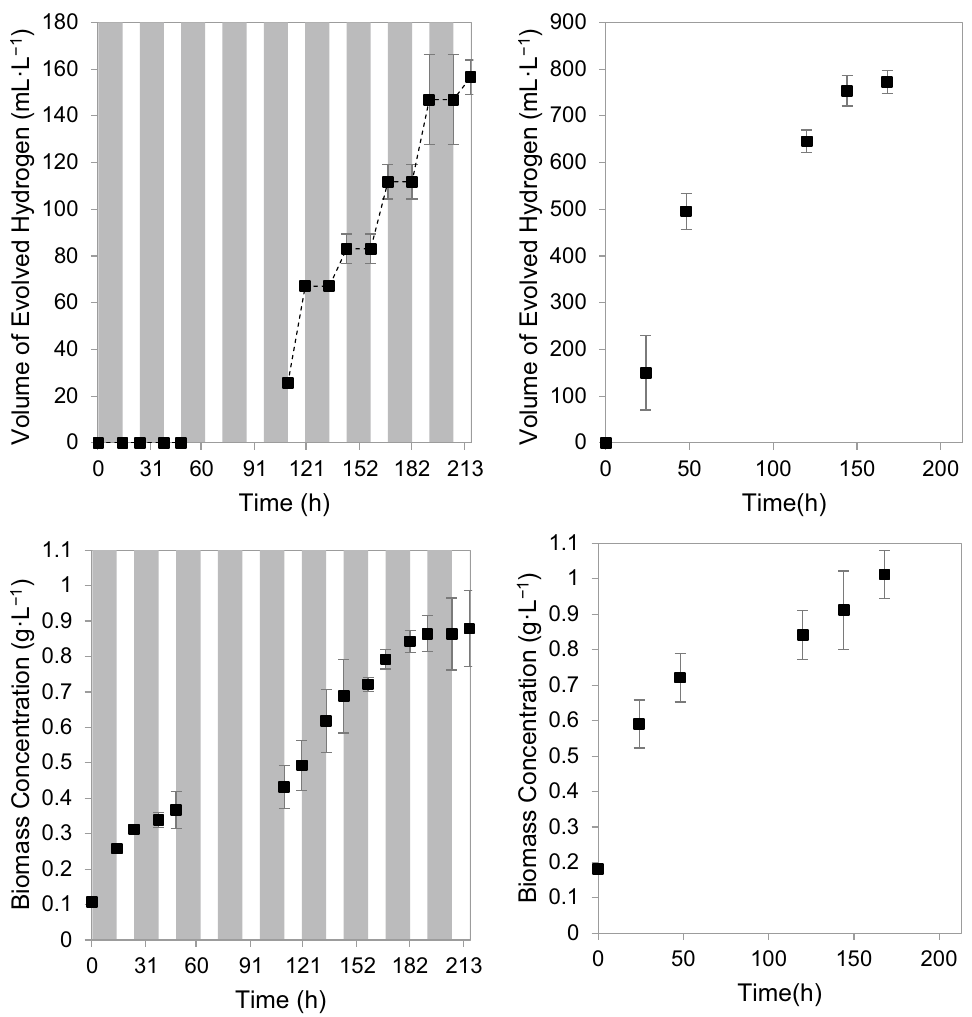
Fig. 2 (Top) Cumulative volume of evolved hydrogen gas per test-tube reactor working volume under (left) diurnal light cycles, and, (right) constant illumination at ~ 500 W m − 2 ( 20 W m − 2 ); and, (Bottom) R. palustris concentration per test-tube reactor working volume under (left) ± diurnal light cycles, and, (right) continuous illumination at ~ 500 W m − 2 ( 20 W m − 2 ) — dark periods indicated with grey areas; each data point ± represents the mean of triplicates with the error indicated as standard